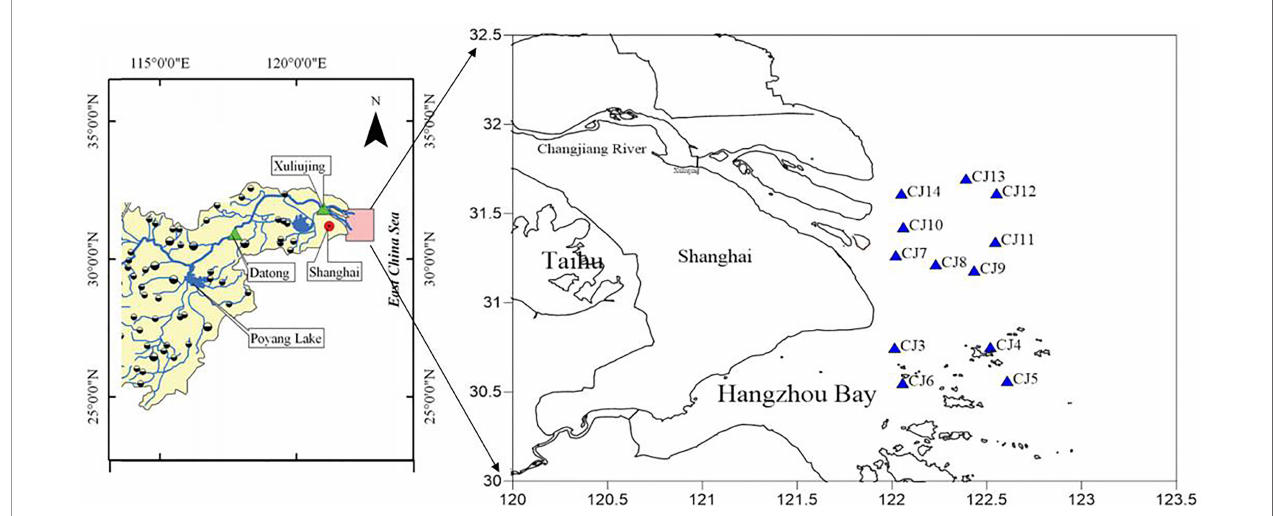
FIGURE 1 | Location of the study area (121.5°-122.8°E, 30.5°-31.8°N) in the Changjiang River Estuary and adjacent coastal waters with monitoring stations CJ3-CJ14 the mixing zone. representative sampling point; representative survey